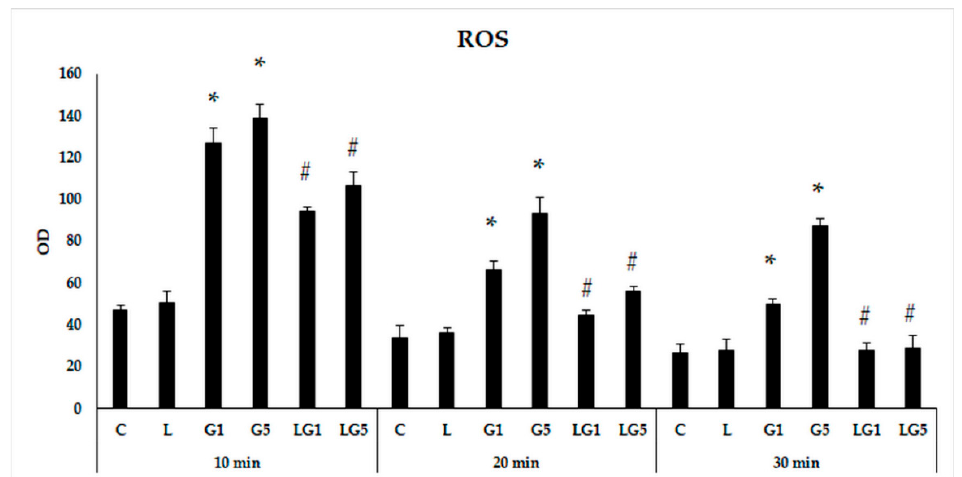
Figure 2. Determination of the effect of lutein on Reactive Oxygen Species (ROS) generated by Glu. SH-SY5Y cells were treated with 10 ng/µL of lutein, 1 mM or 5 mM Glu, or lutein with Glu together to detect the changes in ROS. The cells were incubated for 10, 20, and 30 min at 37 °C and 5% CO 2 . After incubation, the cells were stained with ROS deep red dye solution and incubated for 30 min at 37 °C and 5% CO 2 . The ROS production was determined by a Fluorometric Intracellular ROS Kit. The ROS changes were determined as a percentage of control. The bars represent the mean values (±standard deviation error bars, SD) of three independent experiments ( n = 3), each performed in quadruplicate, and are presented relative to their own control cells. For better transparency, the measured ROS of DMSO controls are not presented, each OD of controls detected between zero to 50. The * marks the statistical significance of Glu treatments compared to control, ǂ marks the statistical significance of lutein treatments compared to control, # shows the statistical significance of combined (lutein with Glu) treatments compared to the Glu treatments at 10 min, 20 min, or 30 min ( p < 0.05). Abbreviations of treatments: L-10 ng/µL of lutein; C-absolute control; G1-1 mM Glu, G5-5 mM Glu, LG1-10 ng/µL lutein with 1 mM Glu; LG5-10 ng/µL lutein with 5 mM Glu, OD-optical density.